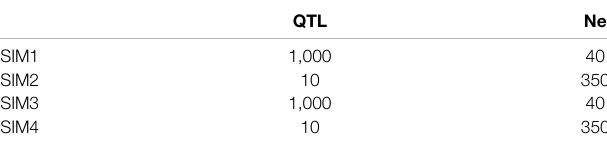
TABLE 1 | Number of QTLs and effective population size in the four different simulated